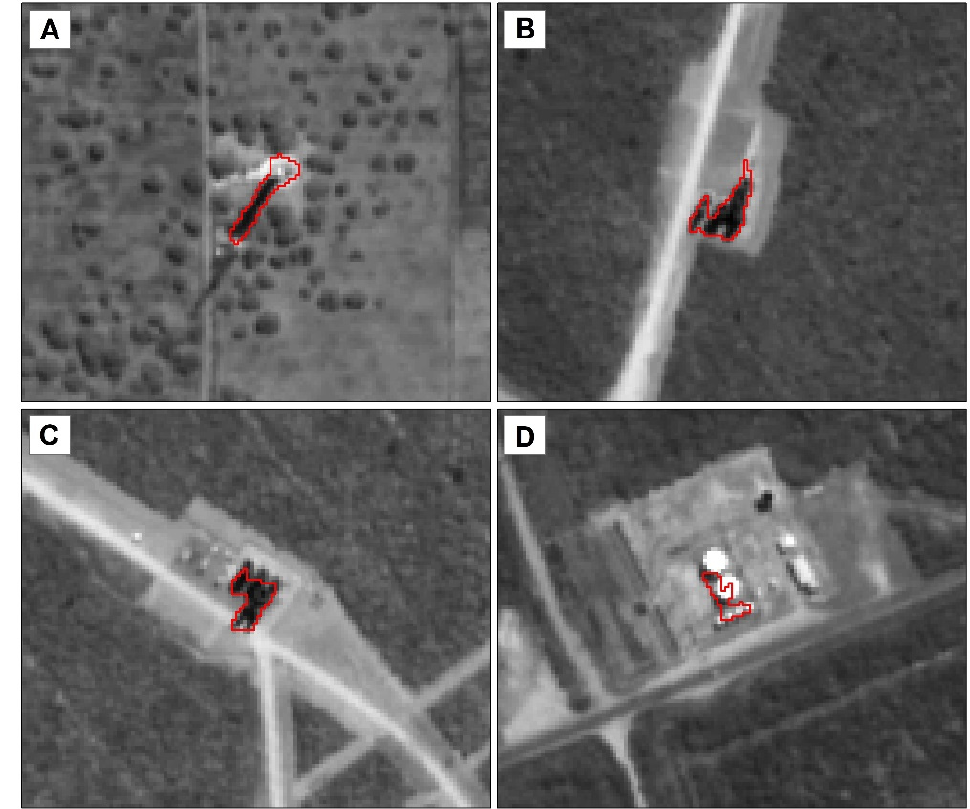
Figure 8. Four error examples ( A – D ) in the final classification.